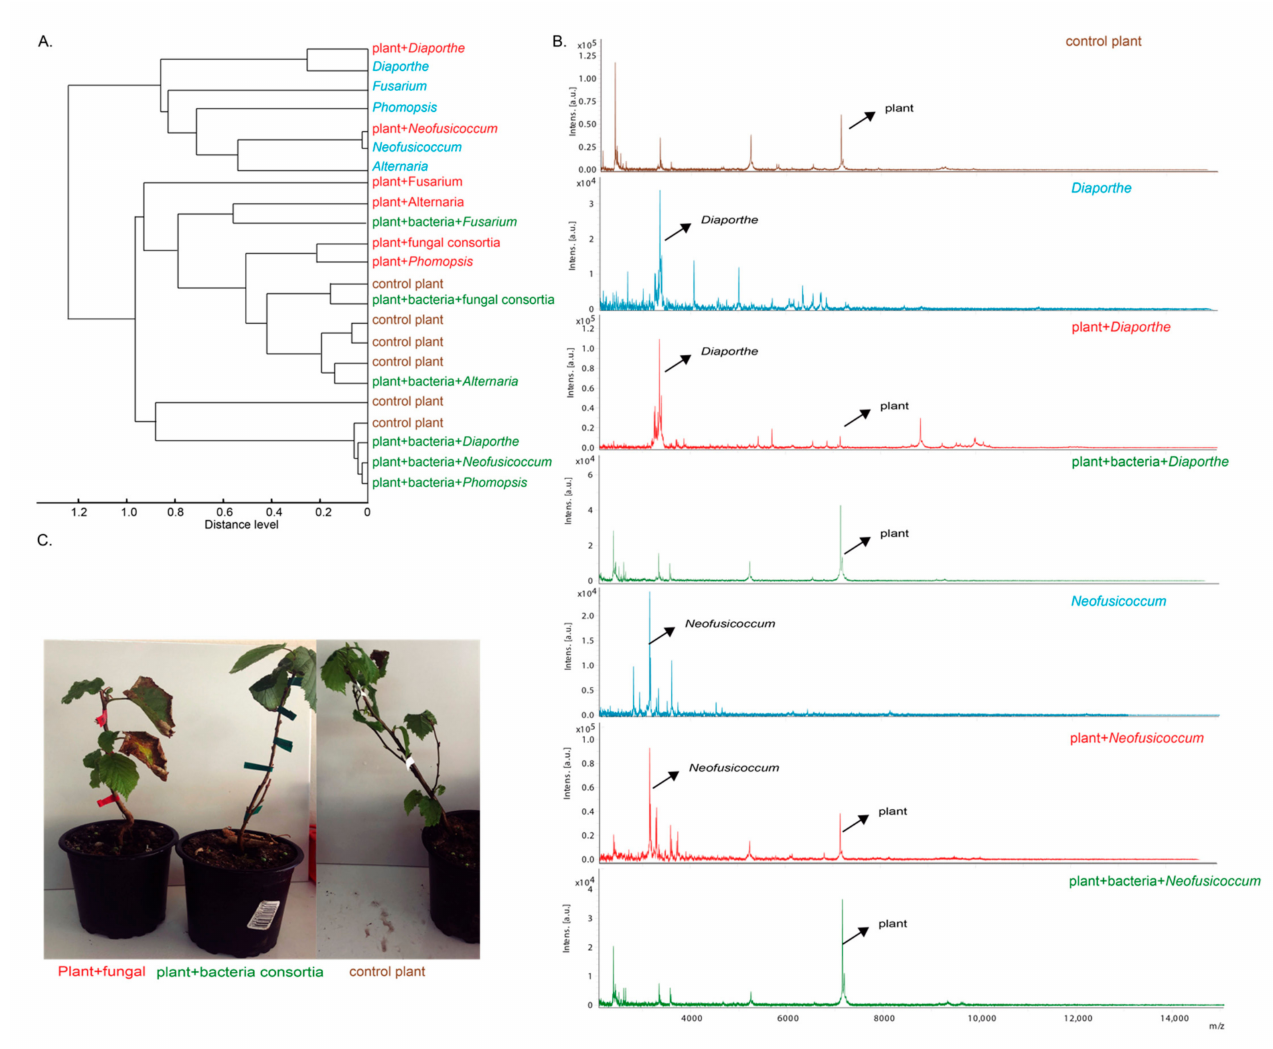
Figure 3. Hazelnut plantscv Barcelona analyzedvia MALDI-TOF/MS. ( A ) Dendrogram and( B ) spectra of protein profiles associated with fungal, plant, plant + fungal and plant + fungal + bacterial consortium, n = 3. ( C ) Symptoms of dieback in hazelnut plants (plant + fungal) and effect of inoculated bacteria (plant + fungi + bacteria consortia) and control healthy plant (without inoculation) n =